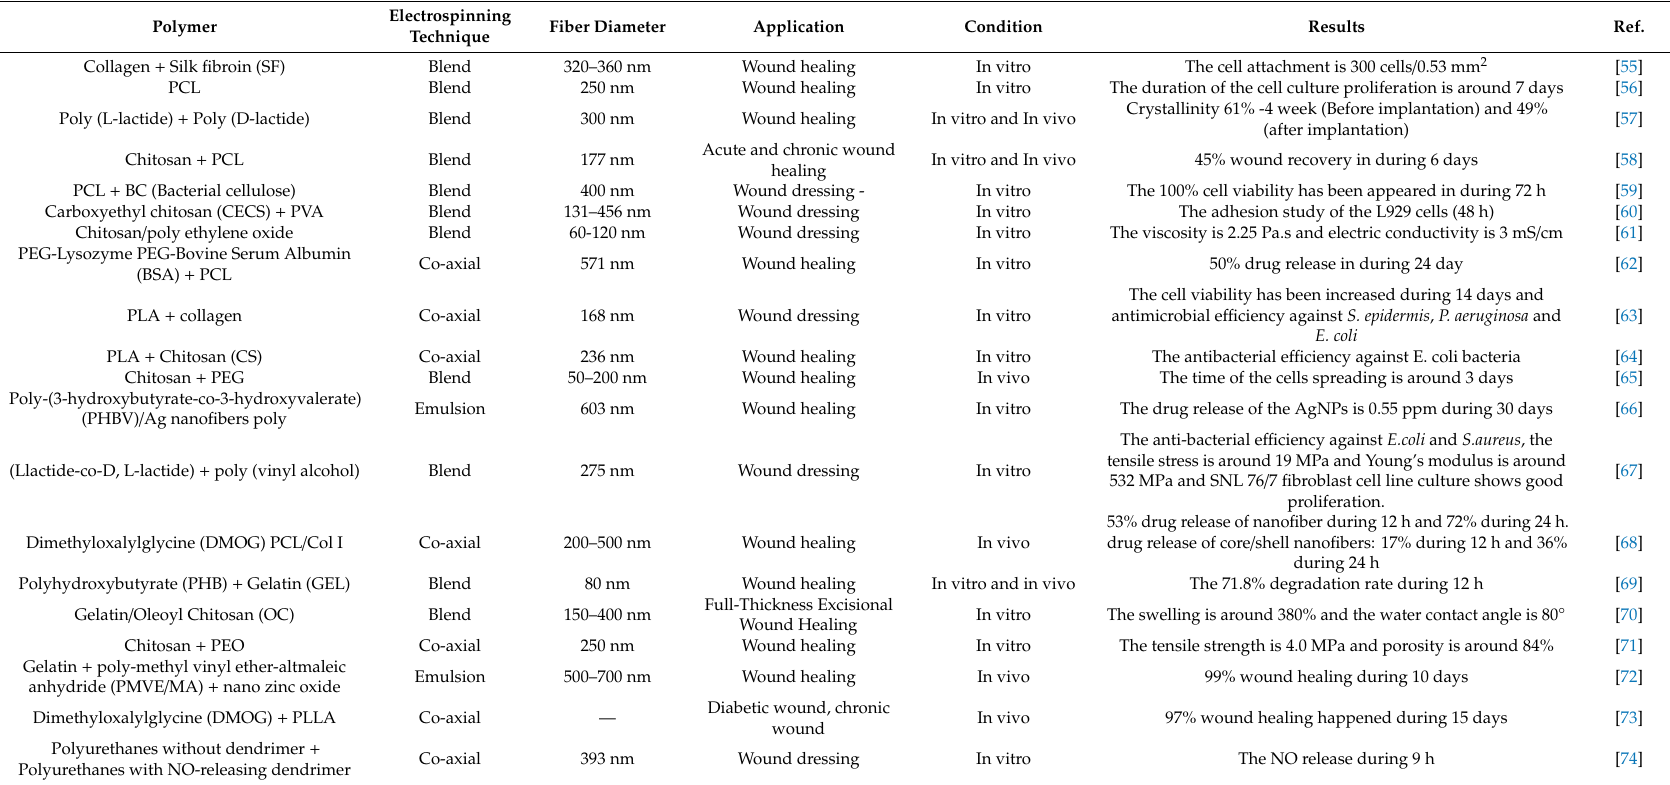
Table 2. E ff ects of electro-spinning equipment setup and their corresponding parameters on the characteristics of polymer-based